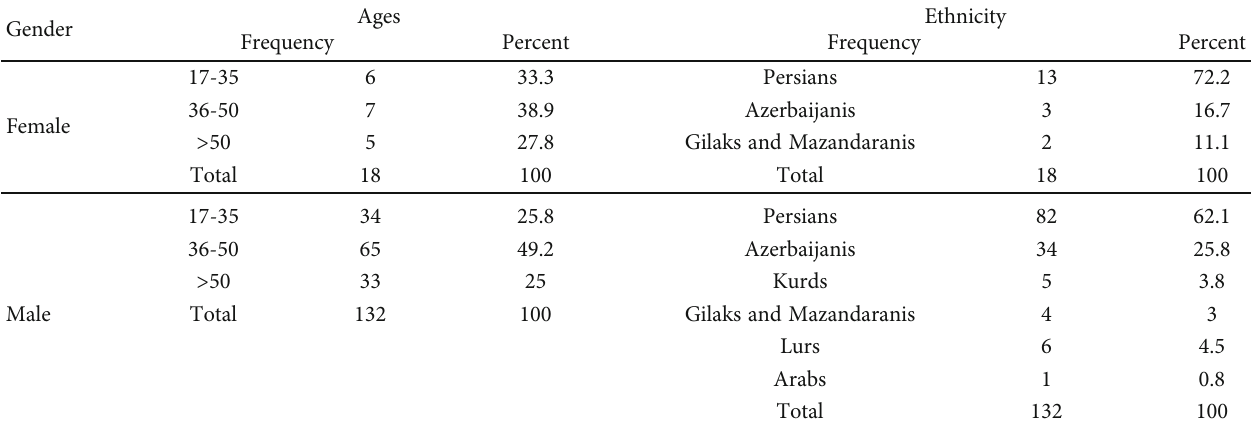
Table 1: The characteristics of study participants. The participants were categorized based on age, gender, and ethnicity. Gender